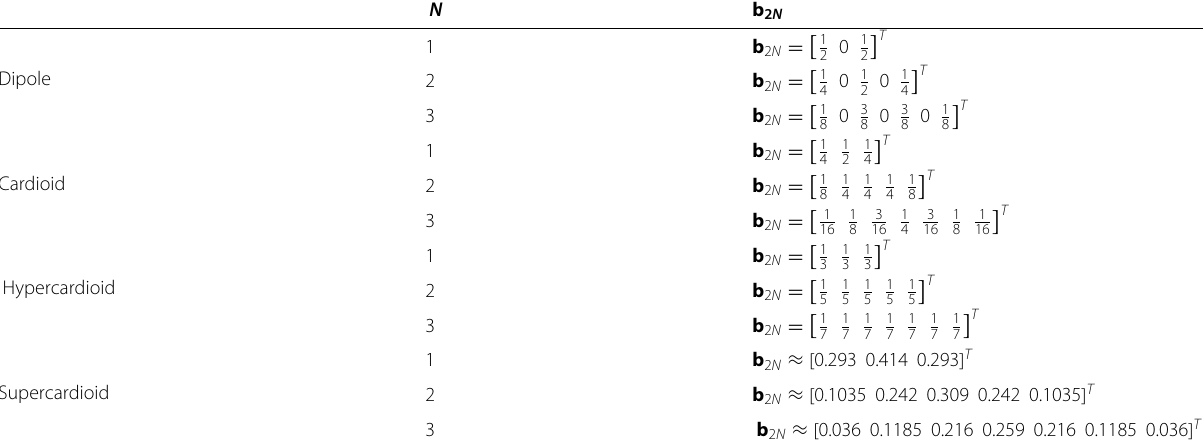
Table 1 Values of the vector b 2 N of the first-, second-, and third-order dipole, cardioid, supercardioid, and hypercardioid